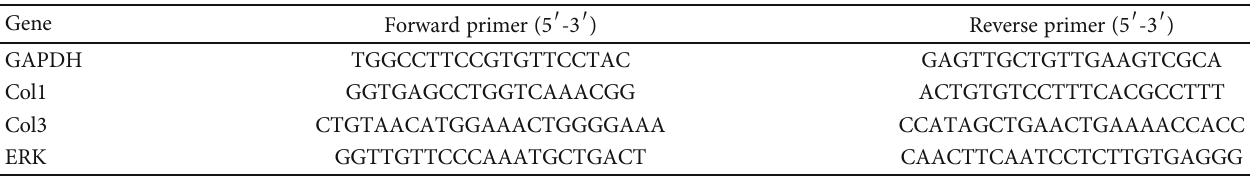
Table 1: Primers used for